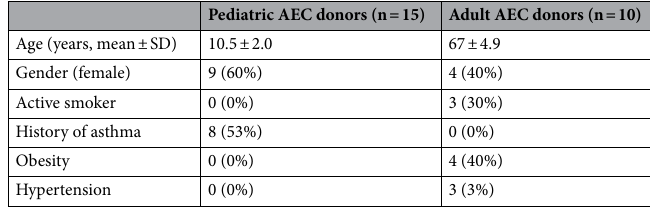
Table 1. Airway epithelial cell donor characteristics. AEC Airway epithelial